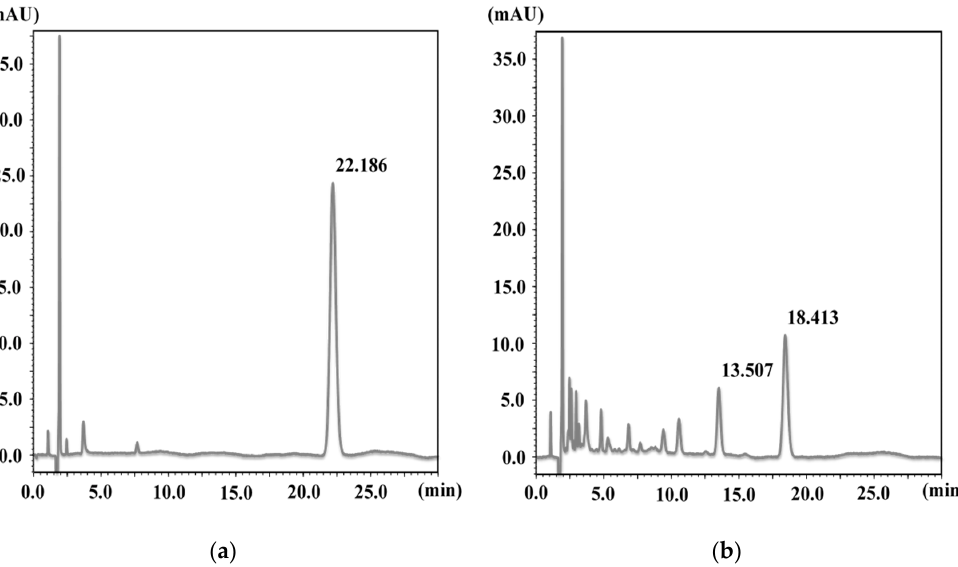
Figure 2. HPLC chromatogram of the ( A ) NX solution and the ( B ) NX solution after UV irradiation for 3 h.